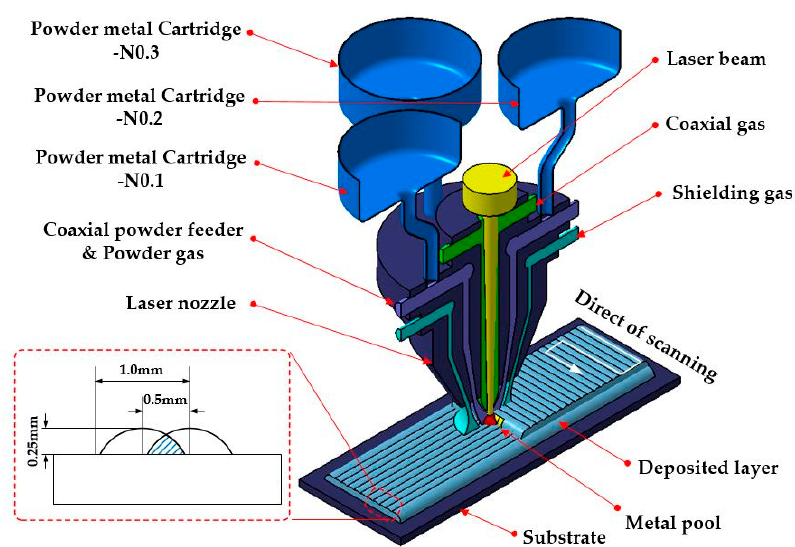
Figure 1. Device configuration and additive layer concept in directed energy deposit (DED)